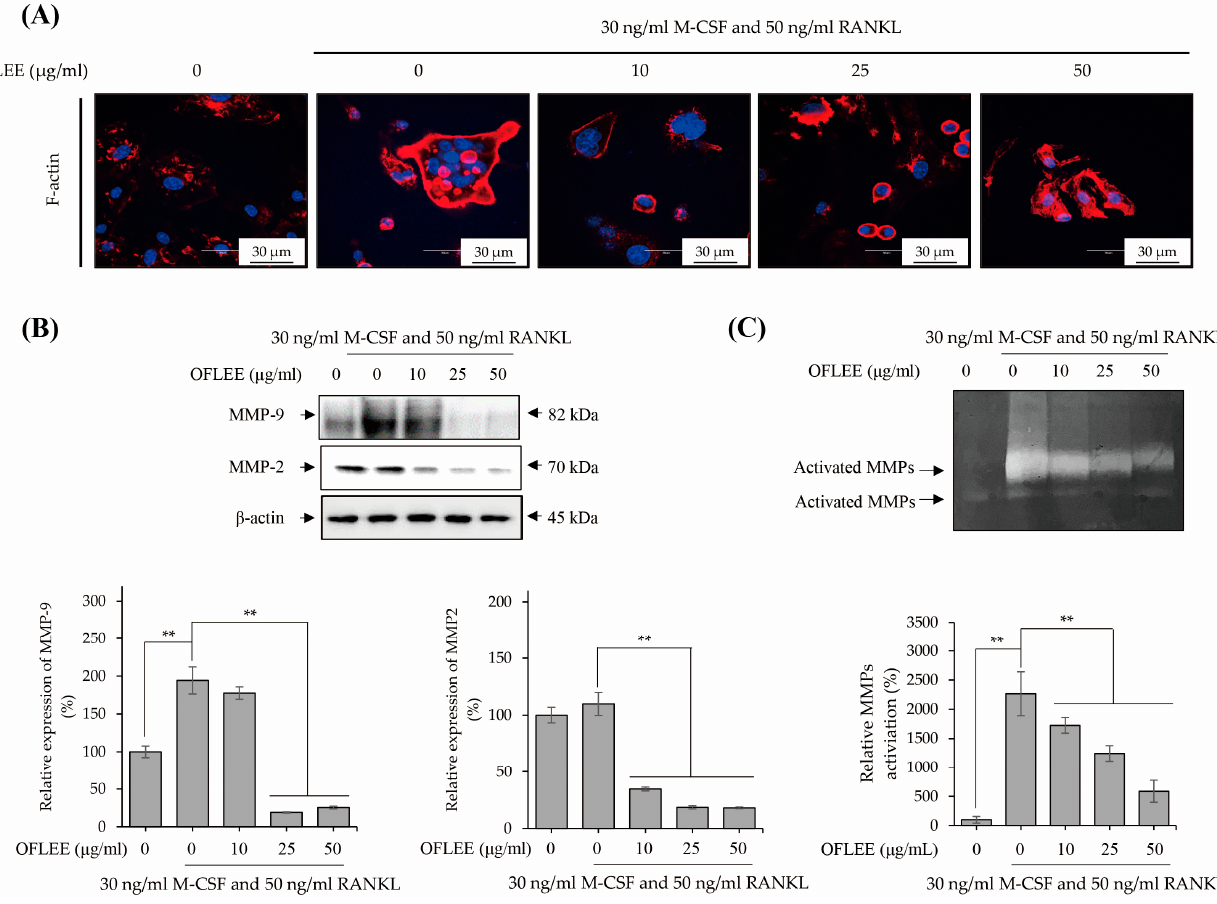
Figure 3. OFLEE suppresses the formation of the F-actin ring and the expression and activation of MMPs in the BMMs treated with M-CSF and RANKL. ( A ) OFLEE suppressed the formation of the F-actin ring in the BMMs treated with M-CSF and RANKL. BMMs were treated with 0, 10, 25, and 50 μ g/mL OFLEE in the presence of 30 ng/mL M-CSF and 50 ng/mL RANKL for 72 h. Thereafter, BMMs were stained with rhodamine-conjugated phalloidin and then stained with DAPI. Images were taken by a confocal laser scanning microscope. ( B , C ) OFLEE inhibited the expression ( B ) and activation ( C ) of MMPs in the BMMs treated with M-CSF and RANKL. BMMs were treated with 0, 10, 25, and 50 μ g/mL OFLEE in the presence of 30 ng/mL M-CSF and 50 ng/mL RANKL for 72 h. Thereafter, the expressions of MMPs in conditioned media were verified by Western blot using MMP-2 and MMP-9 antibodies. In addition, the activity of MMPs in conditioned media were verified by 0.2% porcine skin gelatin zymogram gel. The gelatinolytic bands were captured using a digital camera. Results are mean ± SD of three independent experiments ( n = 3), ** p < 0.01. 2.4. OFLEE Suppresses the Osteoclastic Differentiation of BMMs through the Inhibition